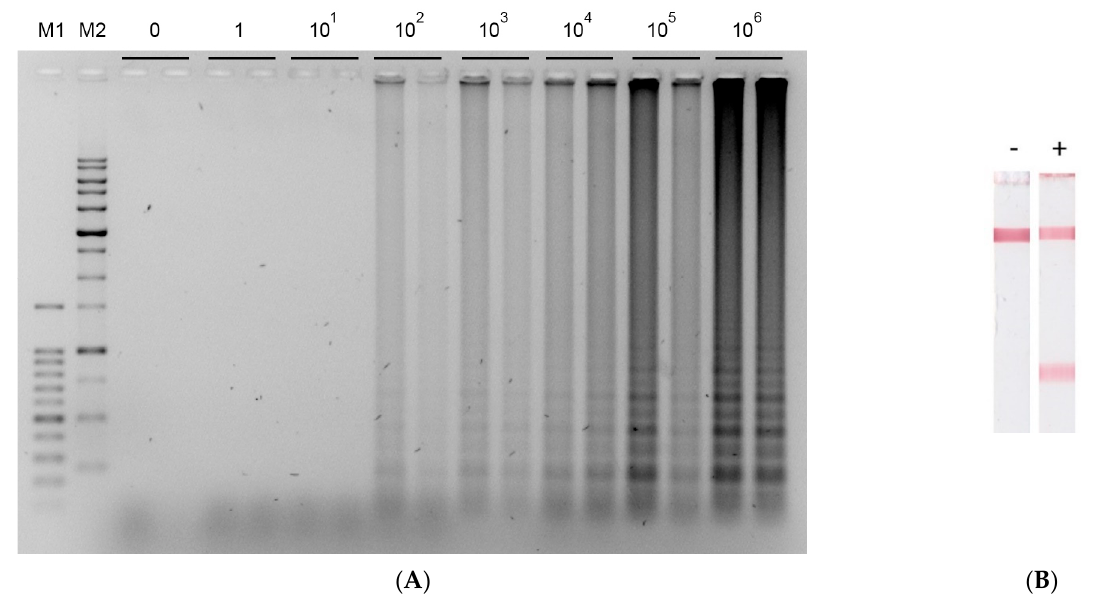
Figure 2. Visualization of LAMP products after amplification of phosphoribosyl transferase gene (gene-1) ( A ) after electrophoresis in 1% agarose gel: 0, 10, 100, 1000, 10 4 , 10 5 , 10 6 copies per reaction, M1 means 100+ bp (100–1500 bp) DNA ladder, M2 means 1 kb (250–10,000 bp) DNA ladder; ( B ) using LFT recognized FAM/biotin labeled amplicons (BL-primer labeled with FAM, BIP primer labeled with biotin) “-” LAMP-LFT without the DNA template, “+” LAMP-LFT in the presence of 10 4 copies of the DNA template.